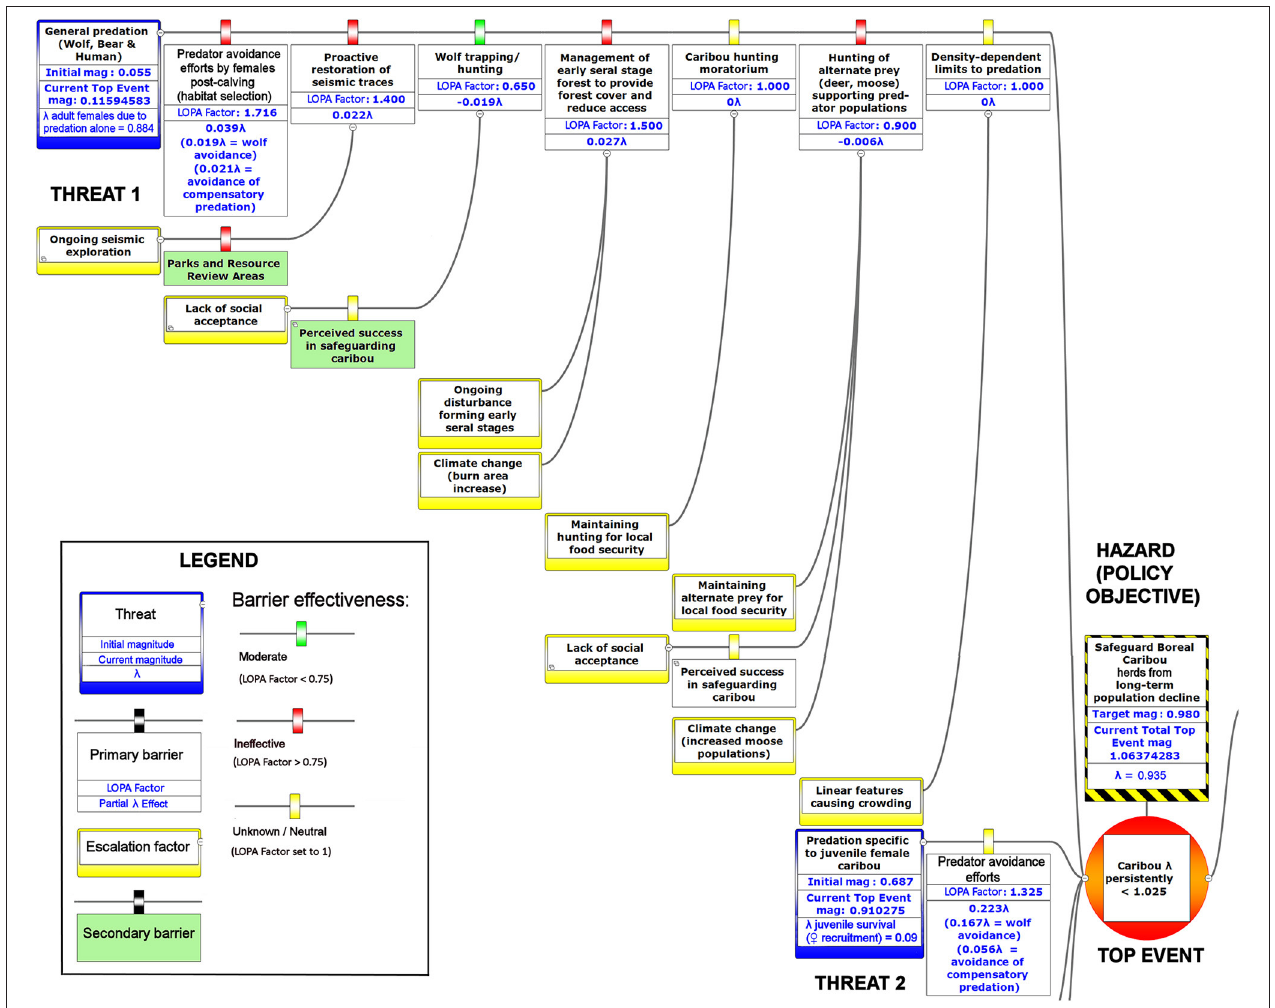
FIGURE 6 | The upper left-hand portion of a bow-tie diagram that visualizes cumulative environmental threats to the boreal caribou meta-population. The top event (red circle, right) is a circumstance where the population growth rate of caribou ( λ ) persistently falls below 1.025. Natural and anthropogenic factors potentially causing the top event are shown in blue boxes on the left panel. Unchecked, the cumulative threats shown in this figure lead to caribou λ persistently < 1.025; the colored boxes placed between threats and the top event show natural factors and human interventions that are potential barriers to the threats. For each threat, relevant factors that increase risks by limiting barrier effects (escalation factors) are shown in yellow boxes linked to the relevant barriers. Secondary barriers that may reduce or nullify the escalation of risk are shown along the lines leading from escalation factors to the primary threat barriers. The numbers appearing in the blue threat boxes correspond to mean current LOPA incidence for the Chinchaga herd (1.0 = 100% probability of occurrence). Numbers in the barrier boxes correspond to the mean current probability-based LOPA factor for barrier or mitigation failure (1.0 = 100%; greater values compensate for natural vs. altered conditions and unfactored threat incidence). The top event box contains target values for sustainable thresholds. To assist with visual interpretation of the LOPA figures, the barriers are color-coded according to the LOPA factor (green < 0.75, red > 0.75, yellow = 1.0 indicating uncertain